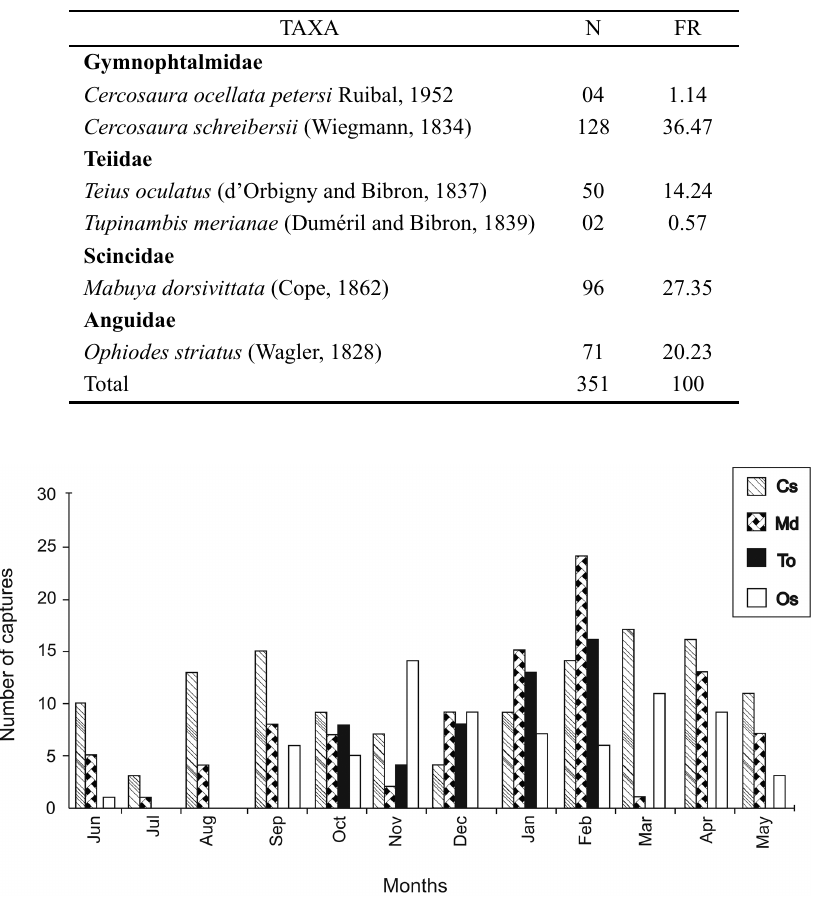
Fig. 1 – Accumulated temporal incidence of individuals from four of the six lizards species recorded in an altered grassy field of southern Brazil, from February 2001 to January 2004. C.s. = Cercosaura schreibersii ; M.d. = Mabuya dorsivittata ; T.o. = Teius oculatus ; O.s. = Ophiodes striatus .